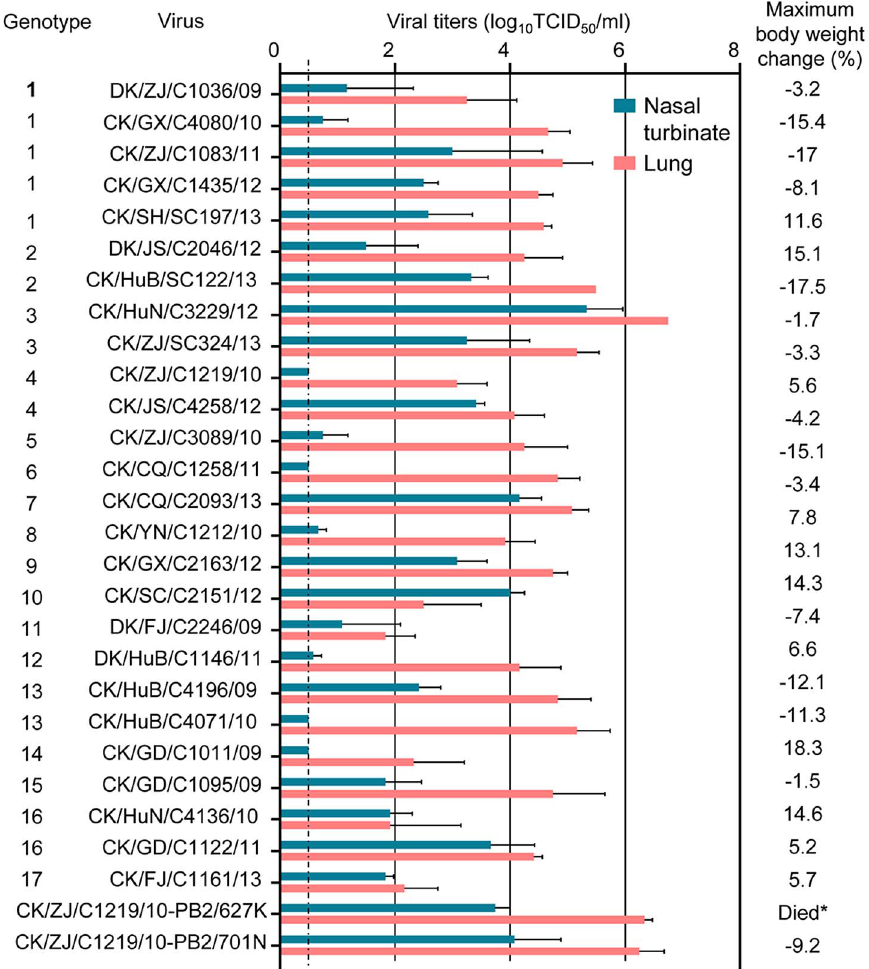
Figure 3. Replication and virulence of H9N2 viruses in mice. Virus titers in organs of mice on day 3 p.i. with 10 6 EID 50 of test virus. Data shown are the mean titers from three mice; the error bars indicate the standard deviations. *, mice inoculated with CK/ZJ/C1219/10-PB2/627K virus died before day 8 p.i. The dashed line indicates the lower limit of detection.